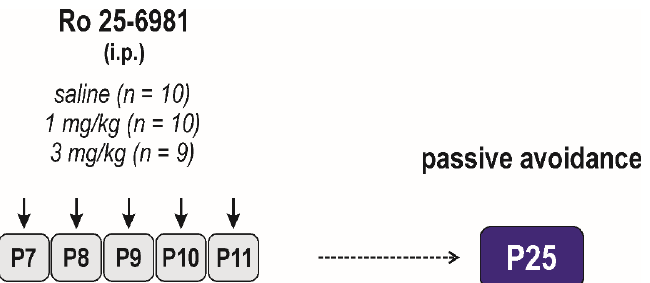
Figure 2. Design/time diagram of the passive avoidance test. Animals were tested at P25, and they were not used for any other test. Other details as in Figure 1.